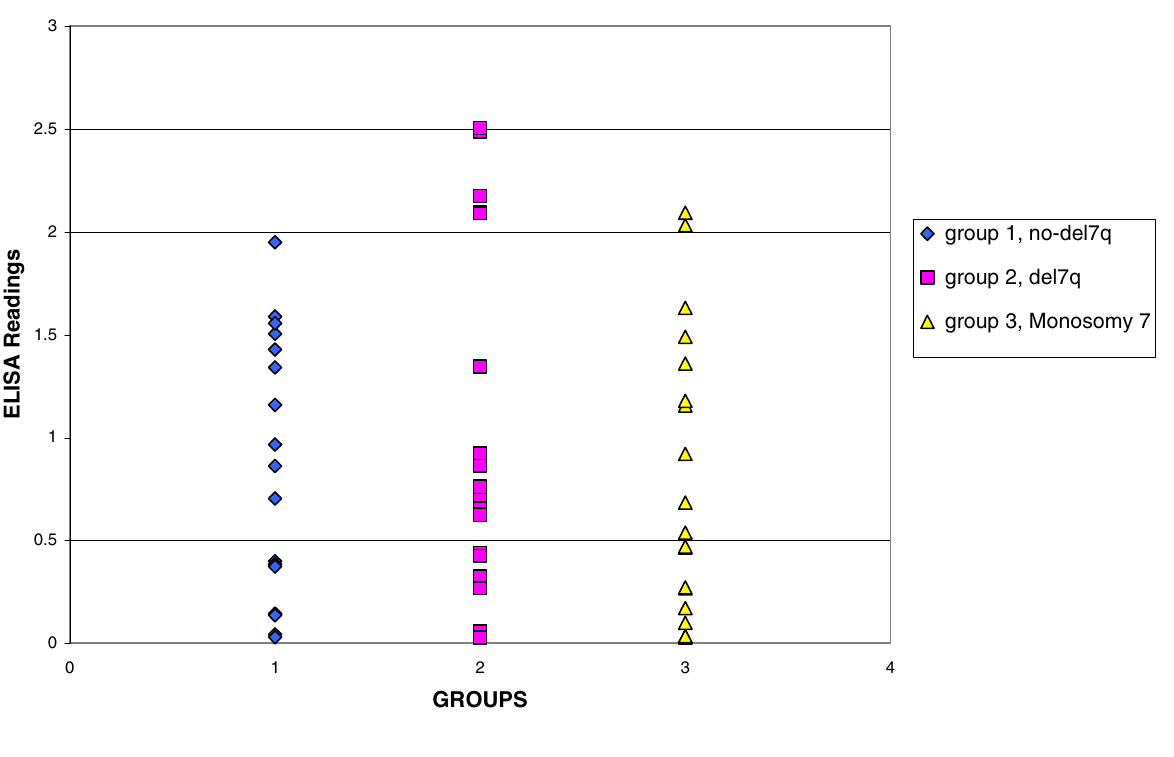
Figure 2 ELISA readings for telomerase activity in the three categories of patient